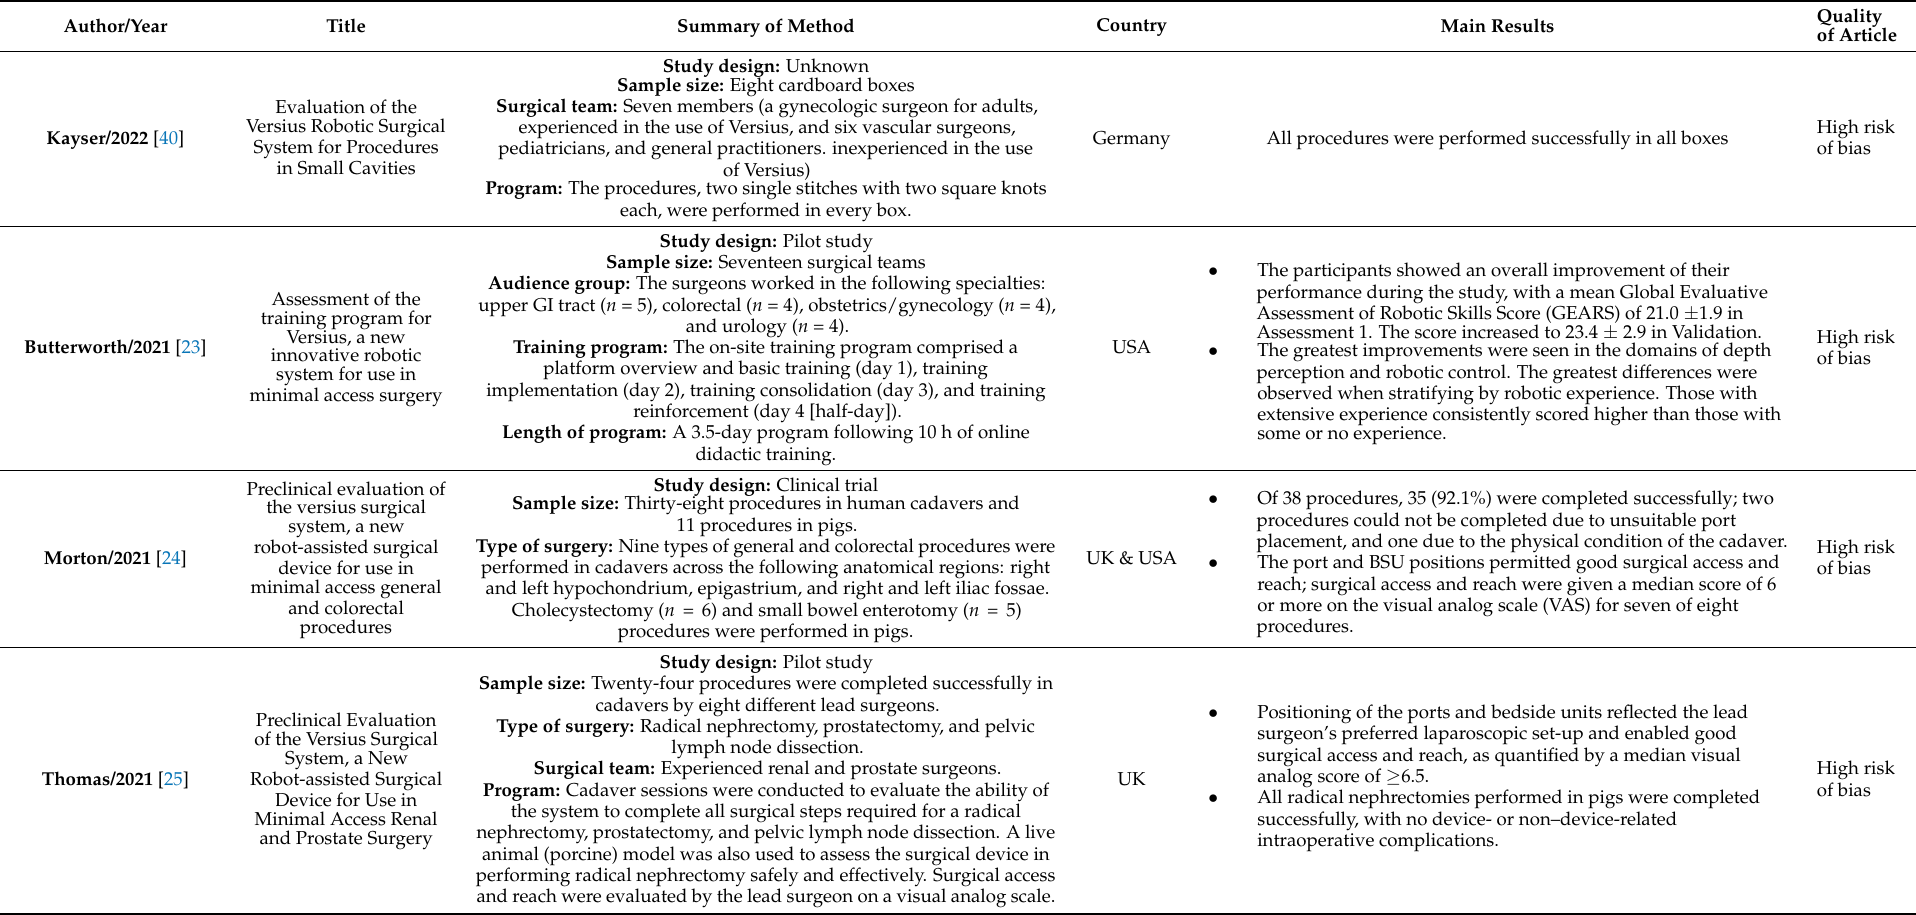
Table 2. Feasibility of the Versius system for healthcare